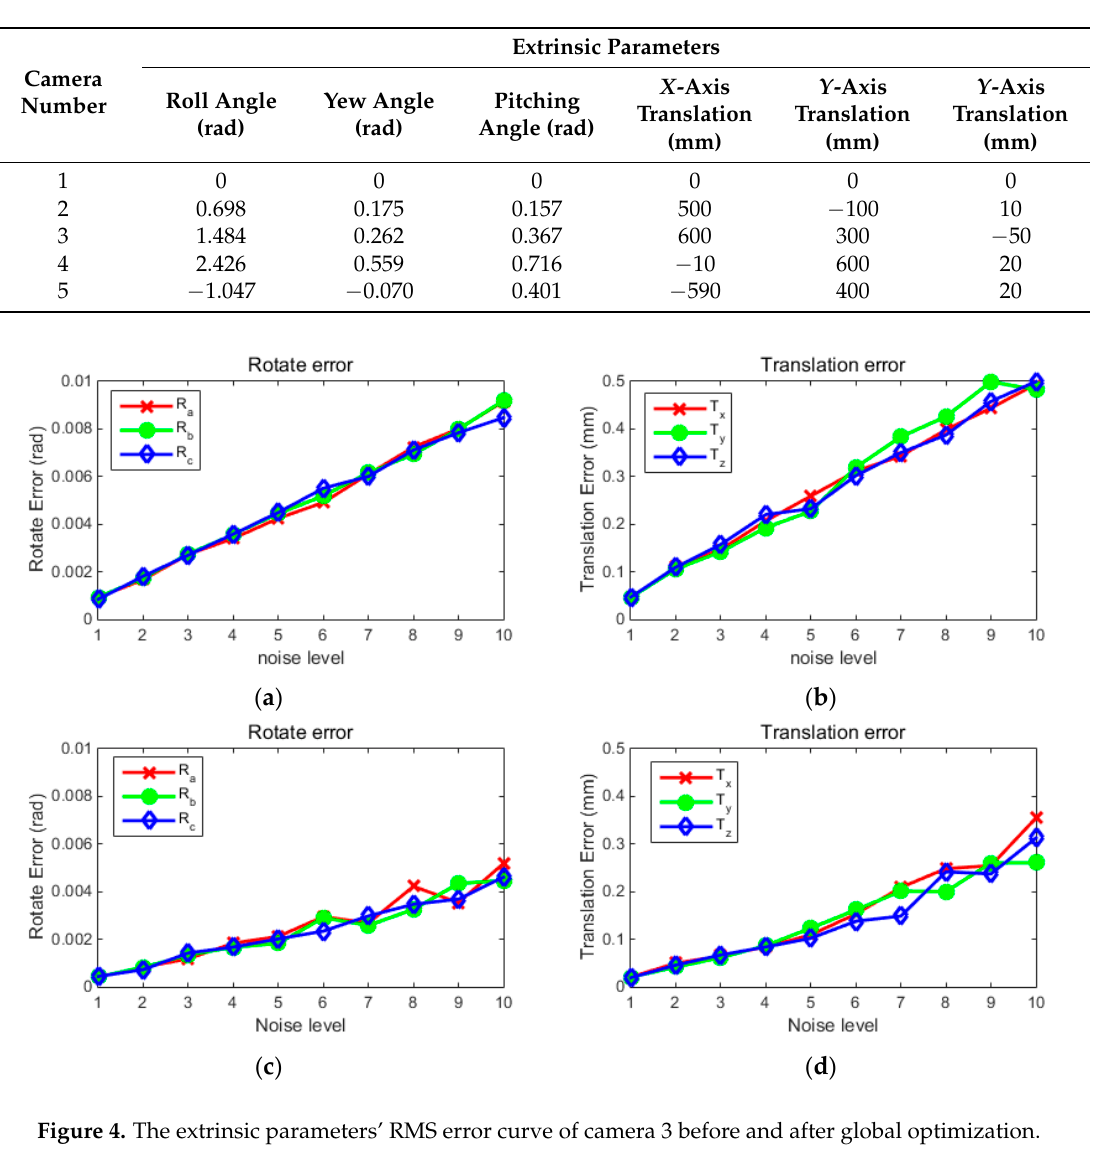
Table 1. The extrinsic of each camera relative to the reference coordinate system.